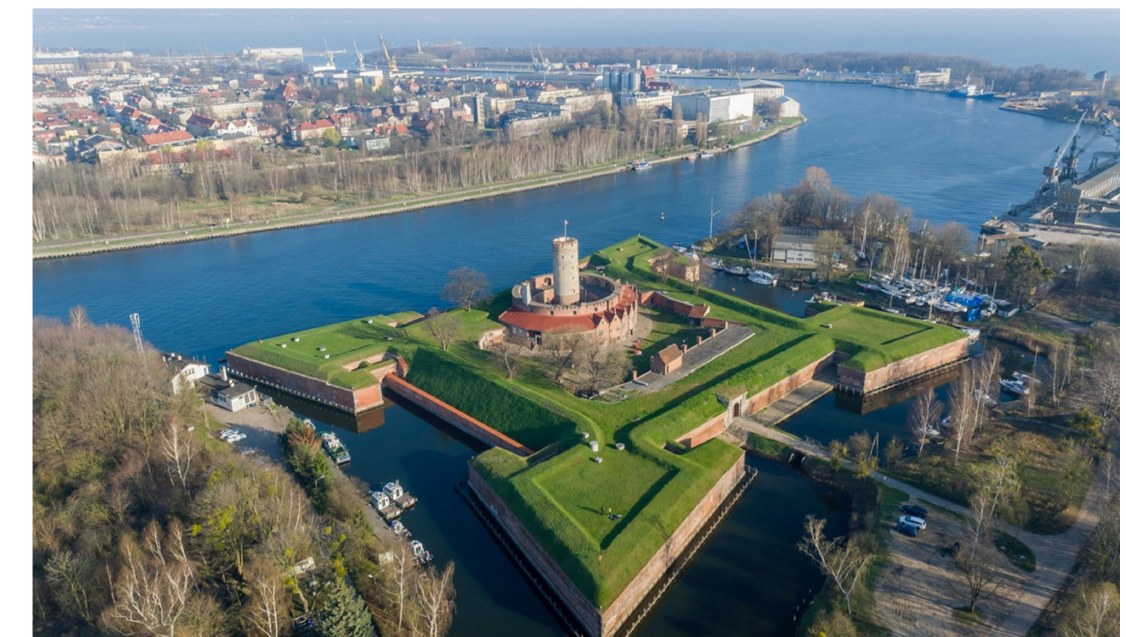
Figure 2. Aerial view of the Wisłouj´scie Fortress historic complex, part of the Natura 2000 site, located by an old estuary of the river Vistula, which flows into the Bay of Gda´nsk. Source: Dariusz Kula/ Museum of